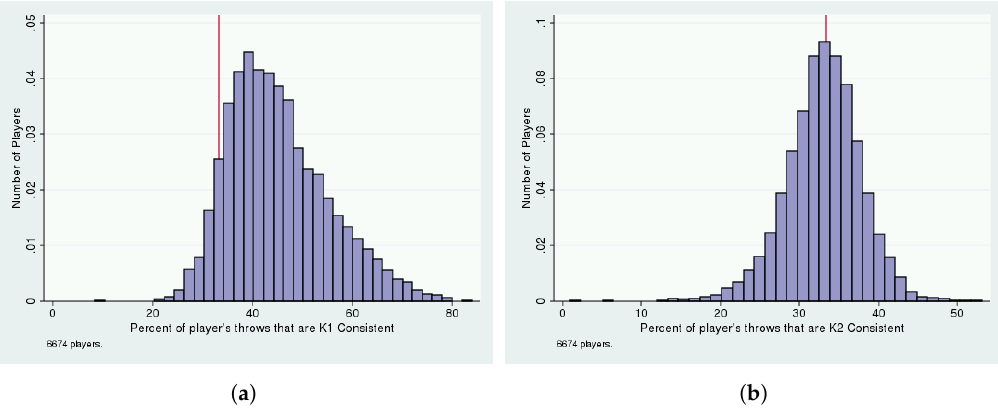
Figure 5. Level- k consistency. Note: These graphs show the distribution across the 6674 players who have 100 games with uniquely defined k 1 and k 2 strategies of the fraction of throws that are k 1 - and k 2 -consistent. The vertical line indicates 1 , which we would expect to be the mean of the distribution 3 if throws were random. ( a ) Percent of player’s throws that are k 1 -consistent. ( b ) Percent of player’s throws that are k 2